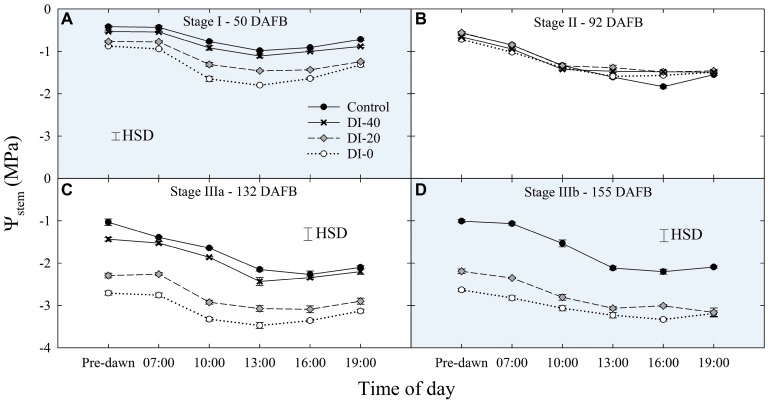
Daily curves of stem water potential (Ψstem) at stages I (A), II (B), IIIa (C), and IIIb (D) of ‘September Bright’ nectarine fruit growth. Trees irrigated to 100% (control), 40% (DI-40), 20% (DI-20), and 0% (DI-0) of crop evapotranspiration. Error bars represent standard errors of means (n = 6). Significant differences determined with analysis of variance and Tukey’s honestly significant difference (HSD, p < 0.05).